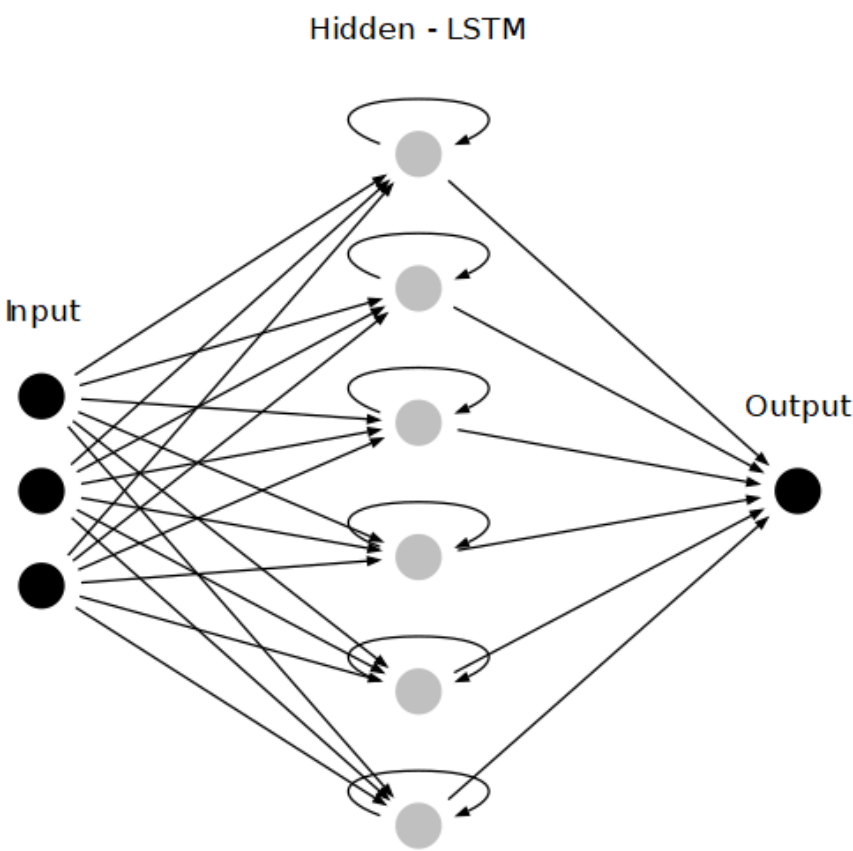
Figure 4. The topology of the machine learning